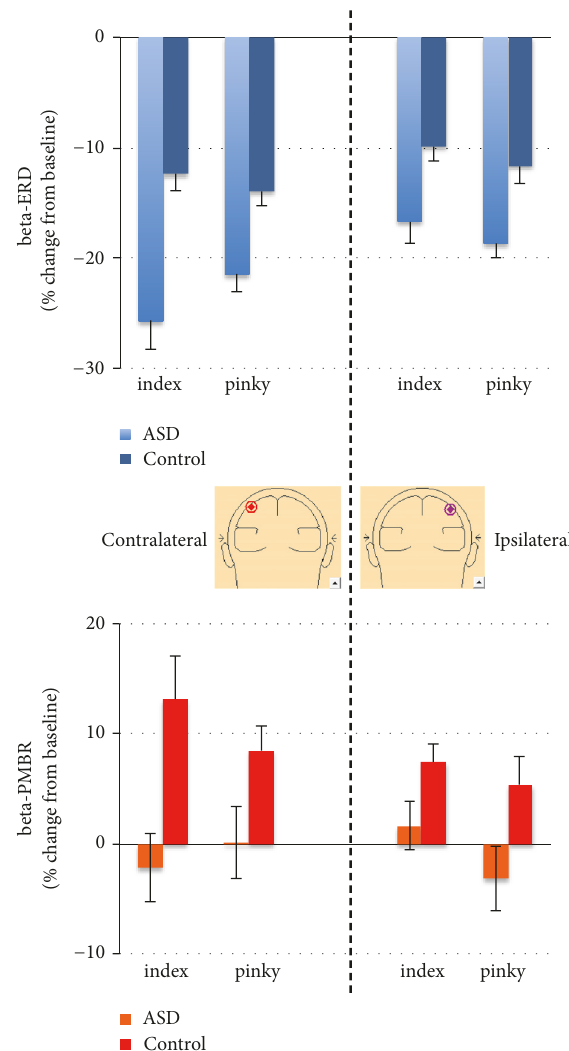
Figure 3: Children with ASD exhibit greater beta-ERD than their control peers but beta-PMBR is absent. Mean (+/- sem) beta-band ERD (top) and -PMBR (bottom) to Index and Pinky Imitation from virtual electrodes contralateral (left) and ipsilateral (right) to right hand of